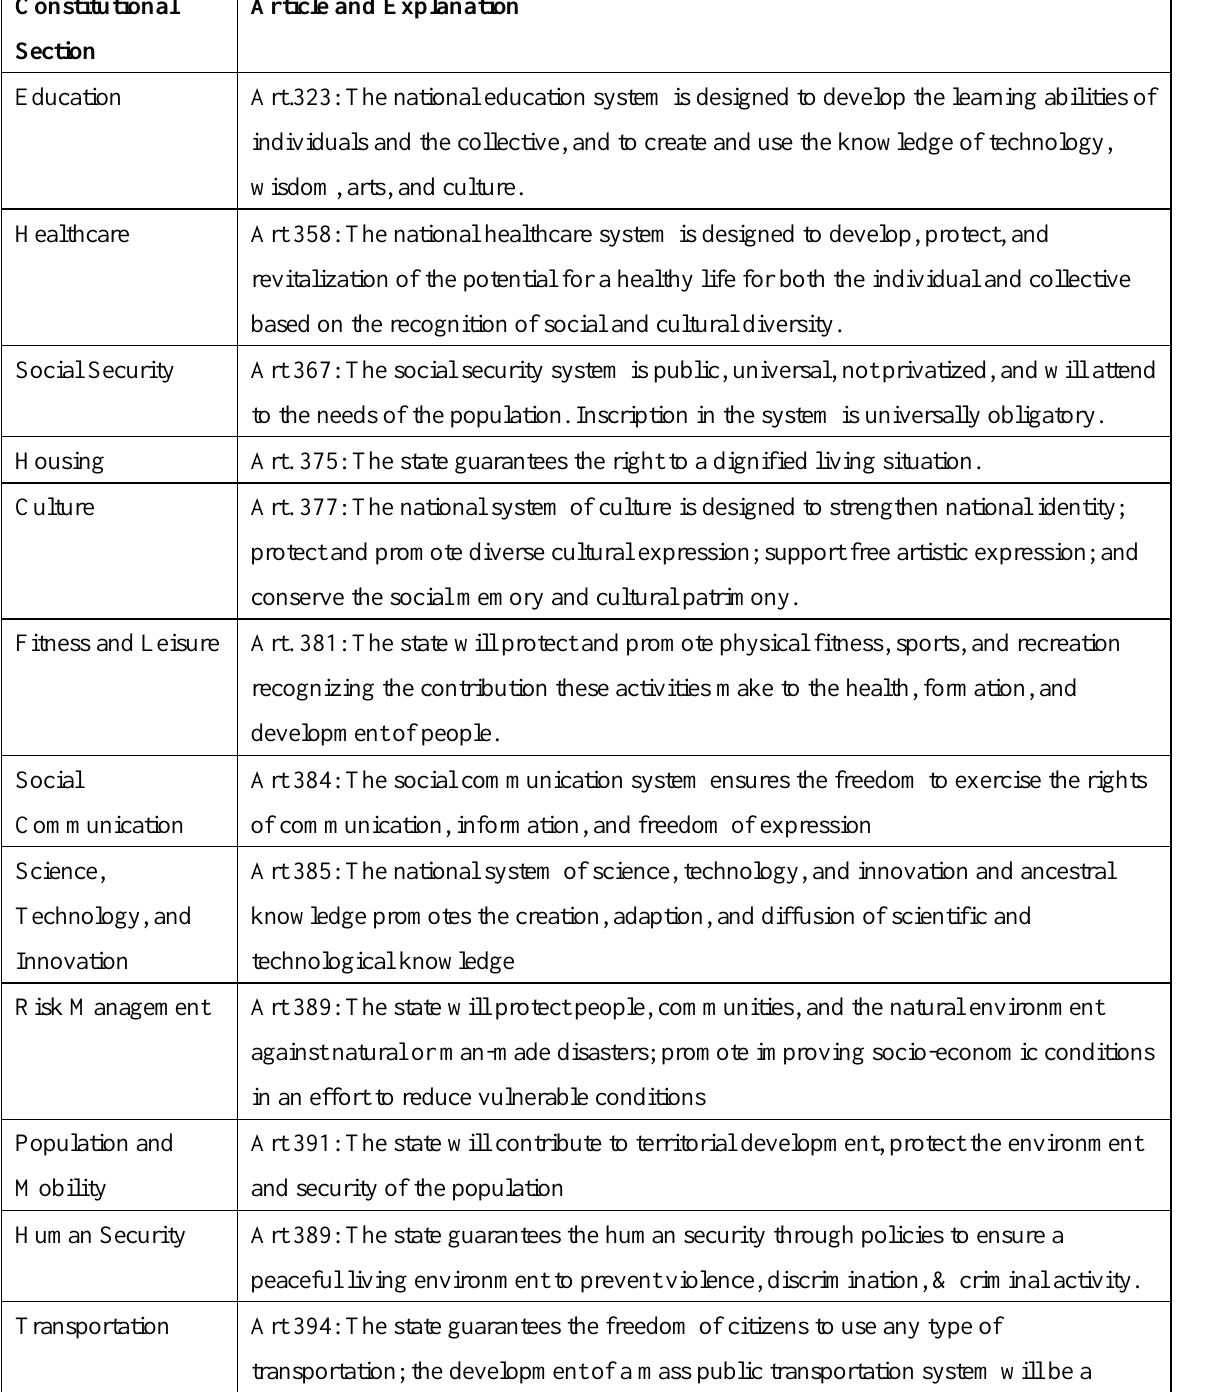
Table 1 . Buen Vivir Regimen, Chapter 1 “Inclusion and Equality” in the 2008